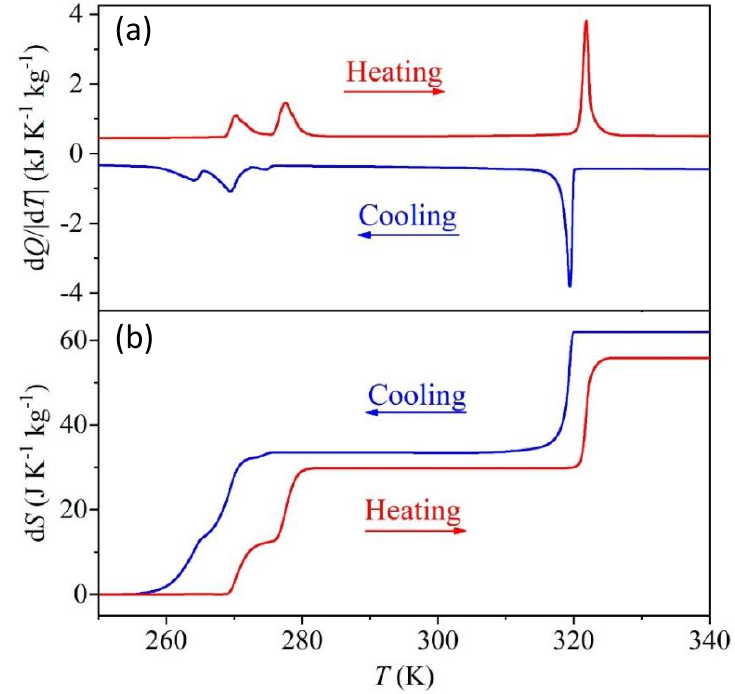
Figure 2. ( a ) Differential scanning calorimetric (DSC) results as a function of temperature obtained by heating and cooling the TMACdN 3 compound. ( b ) Isobaric entropy change as a function of temperature due to the first-order phase transitions α → β → γ and γ → δ (obtained from experiments performed on heating and cooling).